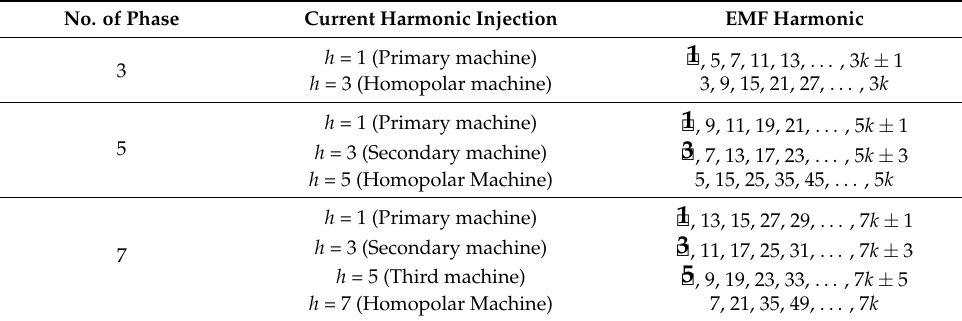
Table 7. Harmonic distribution related to different fictitious machines [36].